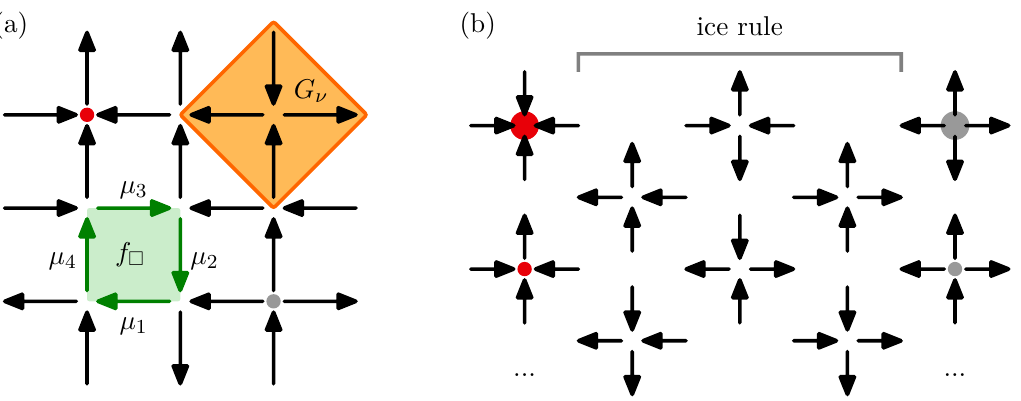
Figure 1: Square ice quantum link model. Arrows visualize spin-1 / 2 polarizations on the links; small (large) red and grey dots indicate positive and negative static charges ¯ c = ± 1 ( ± 2 ) . (a) Lattice configuration with two charges ¯ c = ± 1 and one oriented plaquette (green) which can be flipped by f (cid:131) from counter- to clockwise orientation. The U ( 1 ) gauge symmetry generator G ν counts in- minus outbound arrows at vertices (orange). (b) Vertex configurations: The number of in- minus outbound arrows